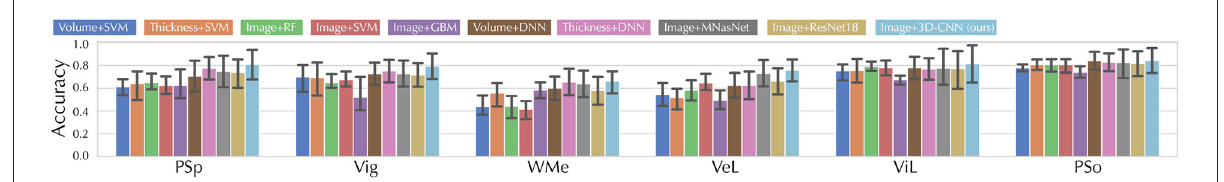
FIGURE2 Accuracy of our model in two-categorized CLC task compared with different ML and DL counterparts in six cognitive estimation dimensions. All the DL models shown were trained from